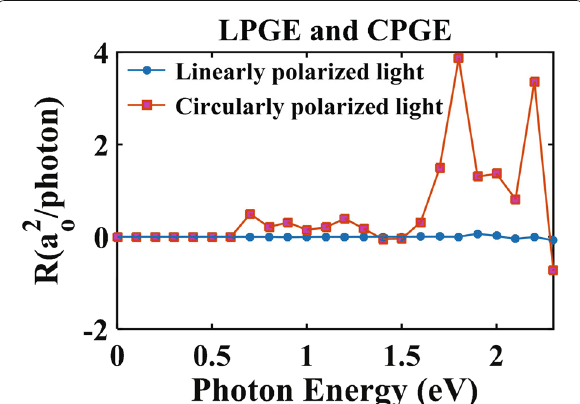
Fig. 3 Variations of photoresponse function with the energies of the linearly polarized light and circularly polarized light, respectively. For LPGE, θ = π/ 4 and φ = 0 ◦ . For CPGE, θ = 0 ◦ and φ = π/ 4. Photon energies range from 0 to 2.3 eV with an interval of 0.1 eV